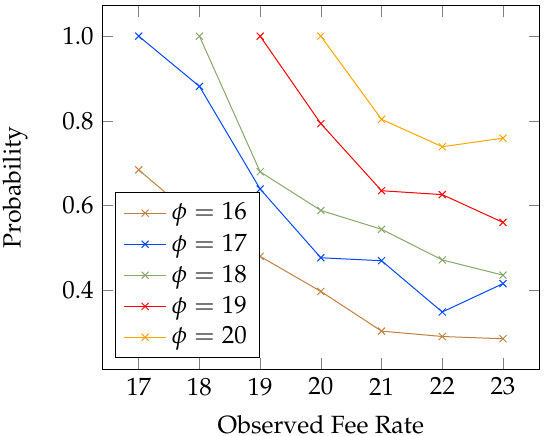
Figure 3. The graph shows how transaction fees influence the probability of confirmation in N blocks. We selected a value of fee rate ( φ ) for the transaction under consideration and then computed how probability changes according observed fee